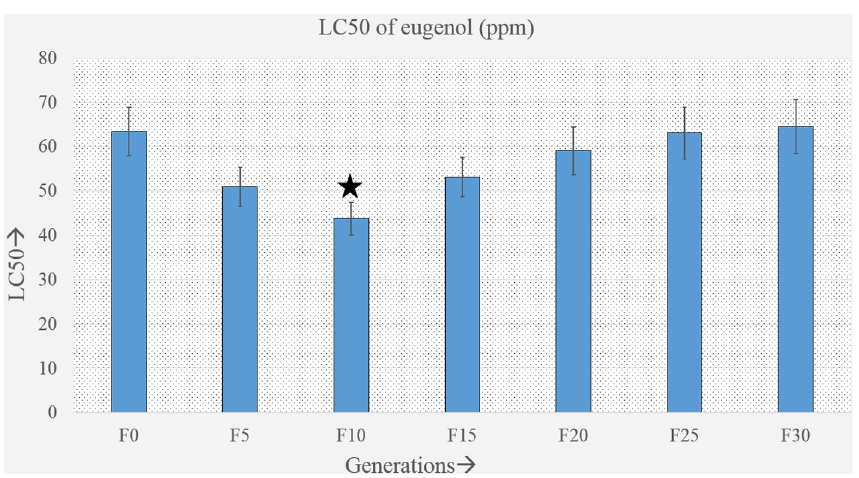
Figure 2. Bar diagram showing the median lethal concentration of eugenol on every fifth successive generations of A. aegypti upto F30 generations. 95% confidence intervals for each LC50 are presented in the form of error